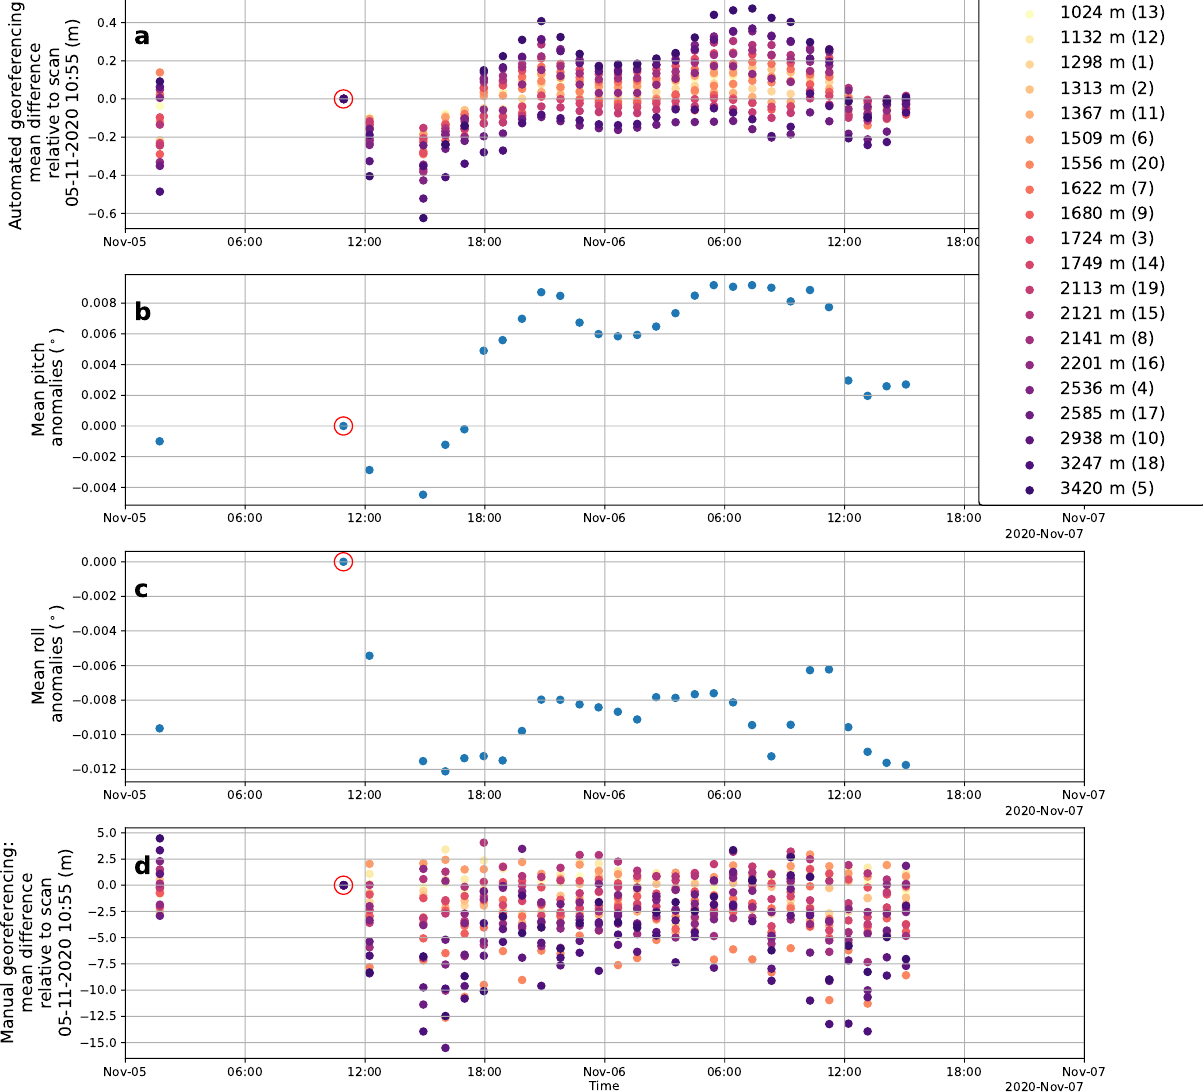
Figure 5. a) Mean difference of 20 selected areas relative to the scan of 5 November 10:55 (red encircled) after automated georeferencing, mean b) pitch and c) roll as measured by the internal inclination sensors and d) mean difference of 20 selected areas relative to the scan of 5 November 10:55 (red encircled) after manual georeferencing. The legend in a) corresponds to the 20 selected areas, sorted to the distance from TLS to target surface; the area number from Fig. 1 is given in